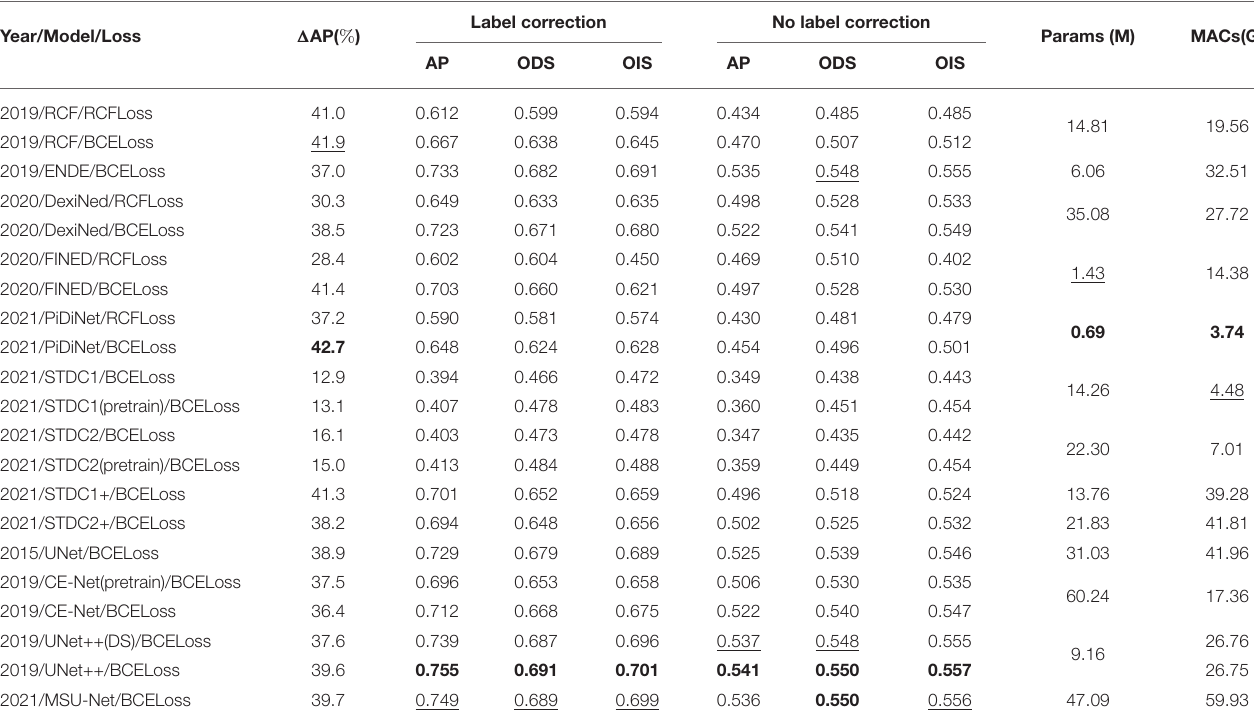
TABLE 3 | Edge detection results on our CCEDD